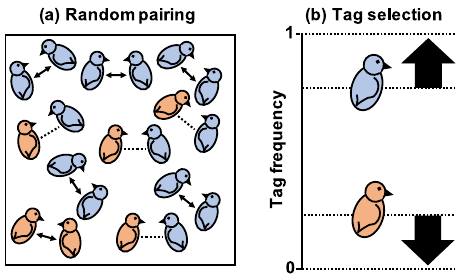
Fig. 1 Crozier ’ s paradox. a Birds with a more common genetic tag (blue) are more likely to encounter birds with the same tag, compared to birds with a less common tag (orange). Consequently, blue birds are more likely to be recognised and helped (arrows). b The blue tag will increase in frequency, while the orange tag will decrease in frequency and be eliminated (positive frequency dependence). Bird cartoons adapted from Levin, Caro, Grif fi n & West, Evolution Letters (ref. 59 ), Creative